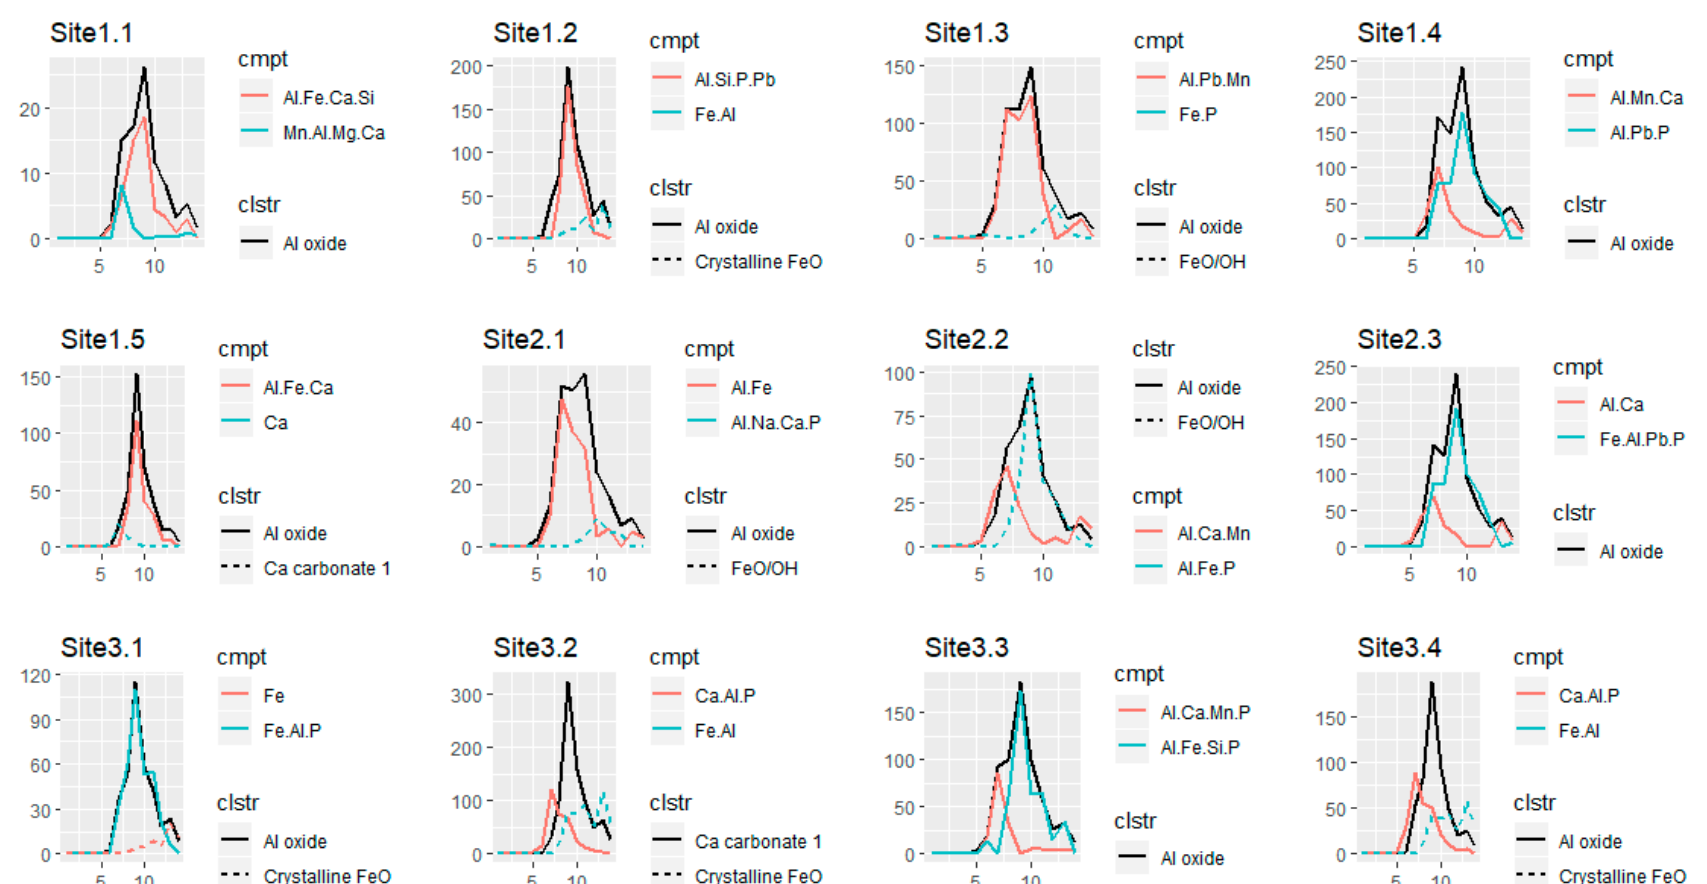
Figure 11. Fractionation of the CISED Pb extraction profile for all soil samples under study. “Cmpt” indicates the original component names which are shown as different colours and “clstr” indicates the clusters to which the components belong, which are shown as different line types (dashed or solid) The two components are those that make up the two main contributing sources of Pb.